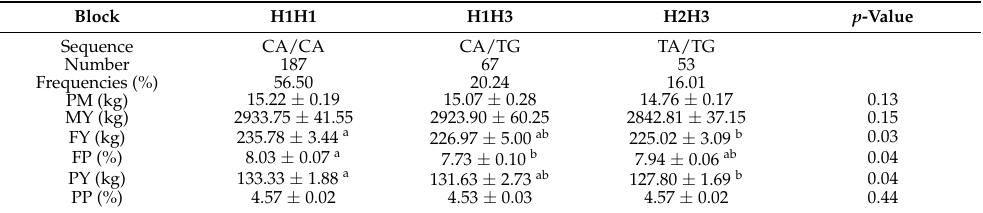
Table 3. Association of haplotype combinations of SQLE with milk production traits in Italian Mediterranean buffaloes.